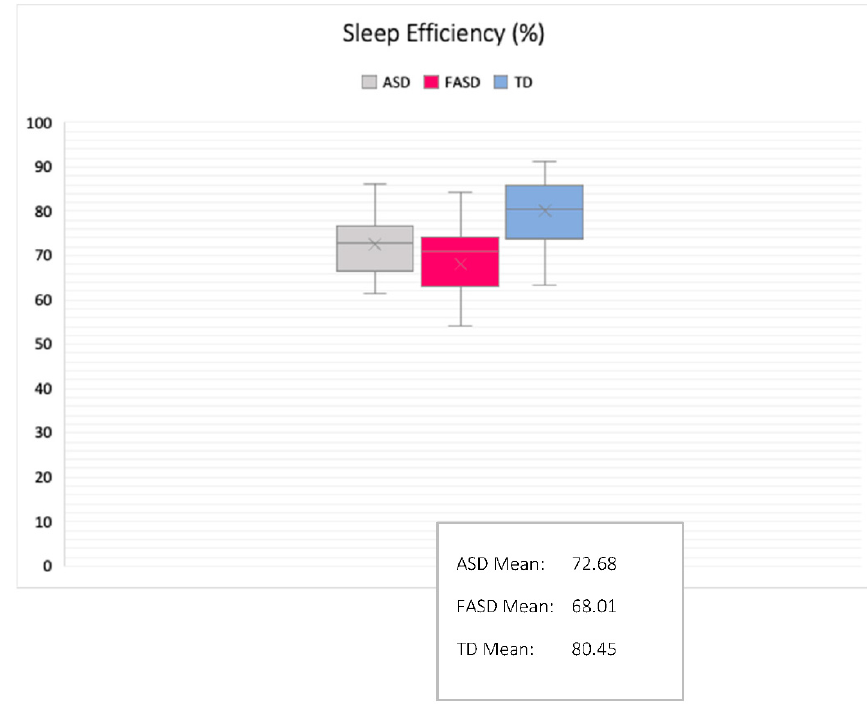
Figure 5. Sleep efficiency as a percentage: comparison between groups (M/SD shown). Figure 5. Sleep e ffi ciency as a percentage: comparison between groups (M / SD shown). Brain Sci. 2020 , 10 , x FOR PEER REVIEW